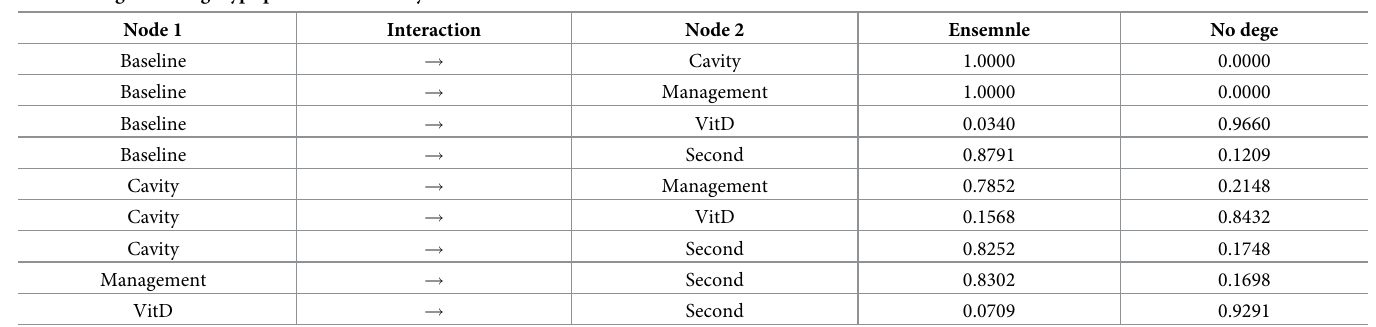
Table 5. Edges and edge type probabilities of Bayesian network node.